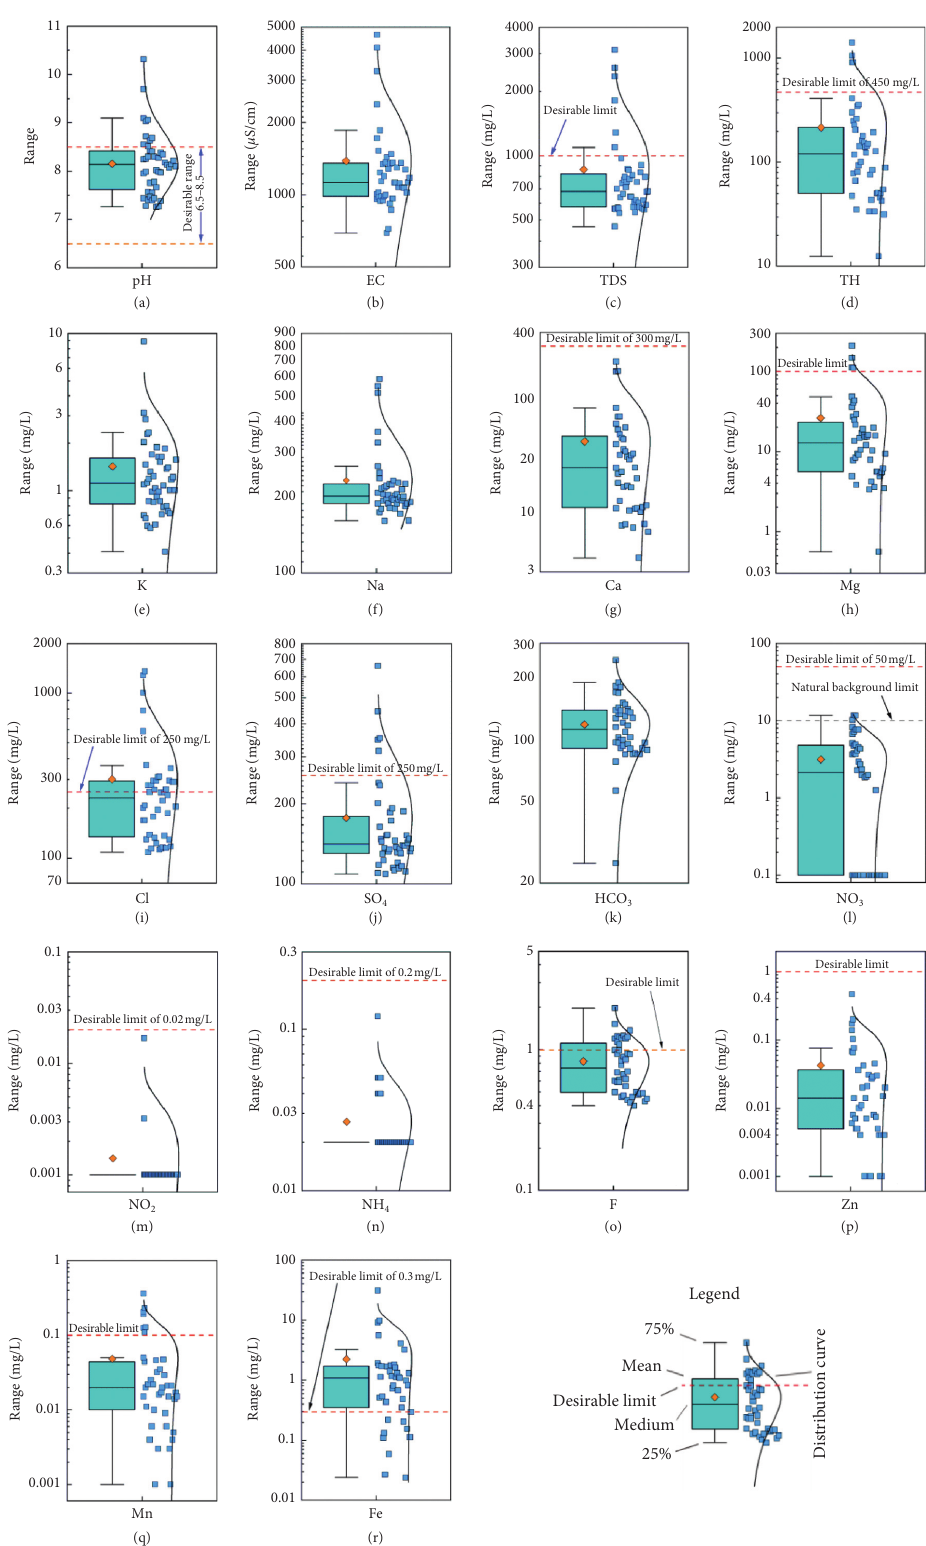
Figure 3: Box plots of physicochemical parameters of groundwater in the study